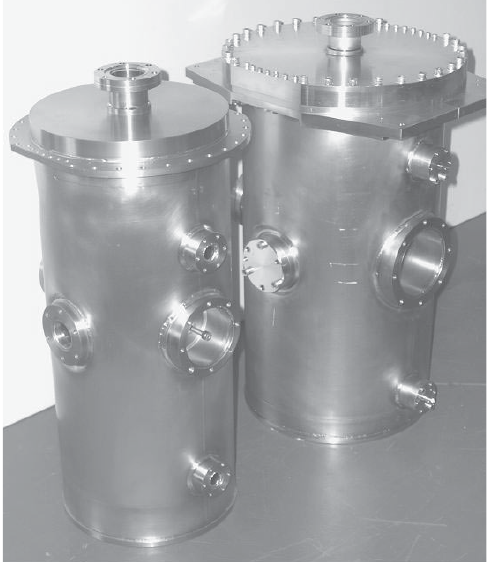
FIG. 1. The INFN-LNL low- (cid:1) (left) and medium- (cid:1) 352 MHz superconducting half-wave